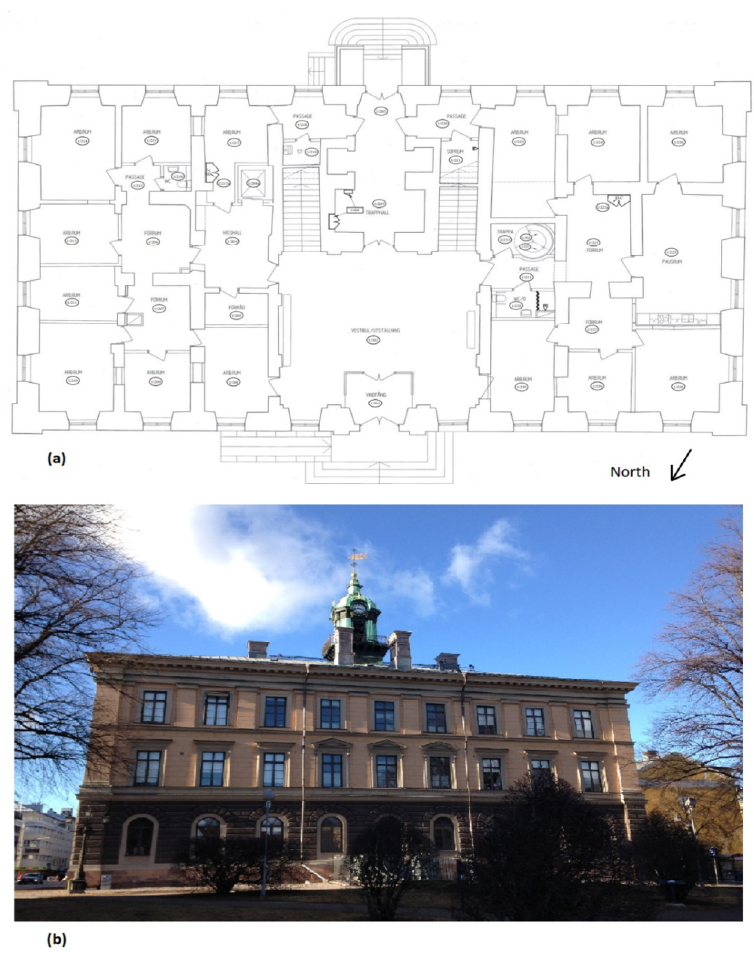
Figure 1. Studied building; ( a ) plan of first floor, ( b ) southeast side of building [15].